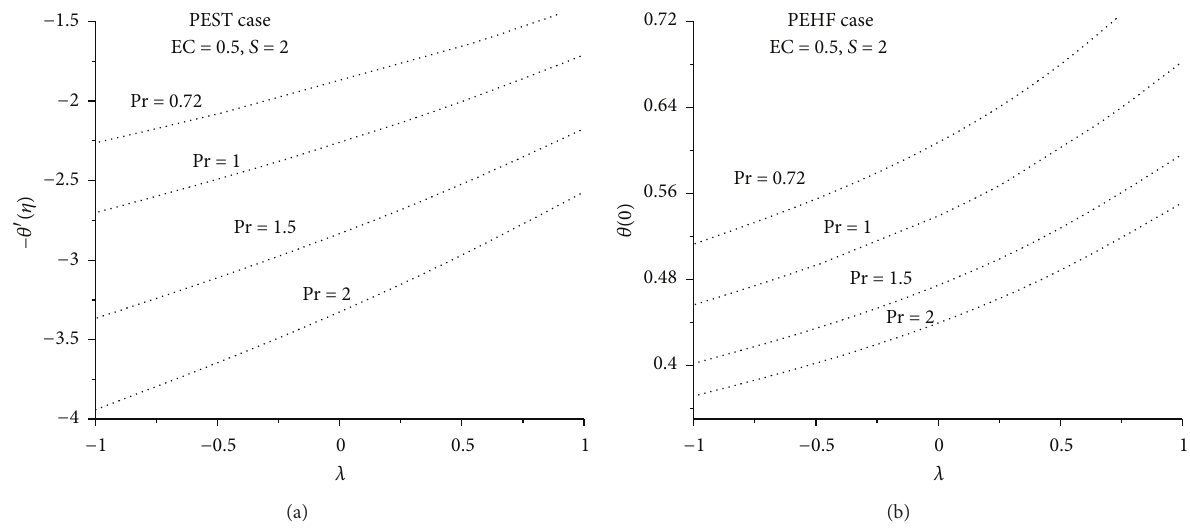
Figure 11: Heat transfer characteristics for different values of Pr and 𝜆 for both PEST and PEHF cases.